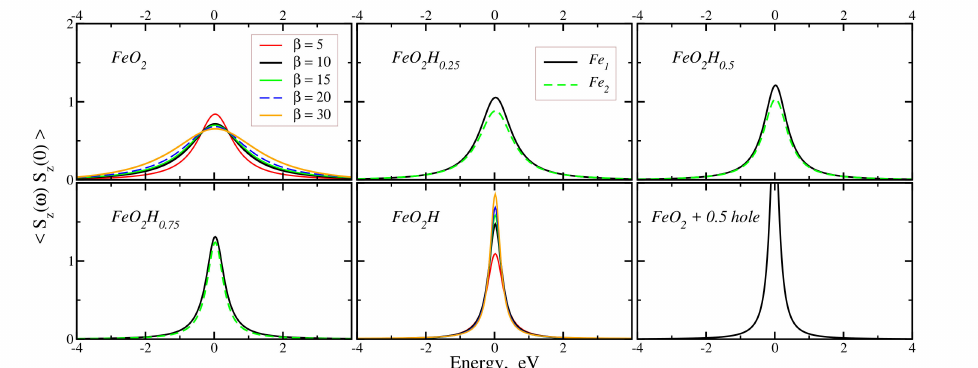
Figure 3. (Color online) FeO 2 H x spin–spin correlation functions for different values of concentration, x , at β = 10 eV − 1 . Left-top panel: the temperature dependence for pure FeO 2 . Middle-top, right-top, left-bottom: local spin–spin correlation functions for the corresponding concentrations. Middle-bottom: the temperature dependence for FeO 2 H. Right-bottom: the spin–spin correlation function for FeO 2 + 0.5 hole ( χ loc ( 0 ) ≈